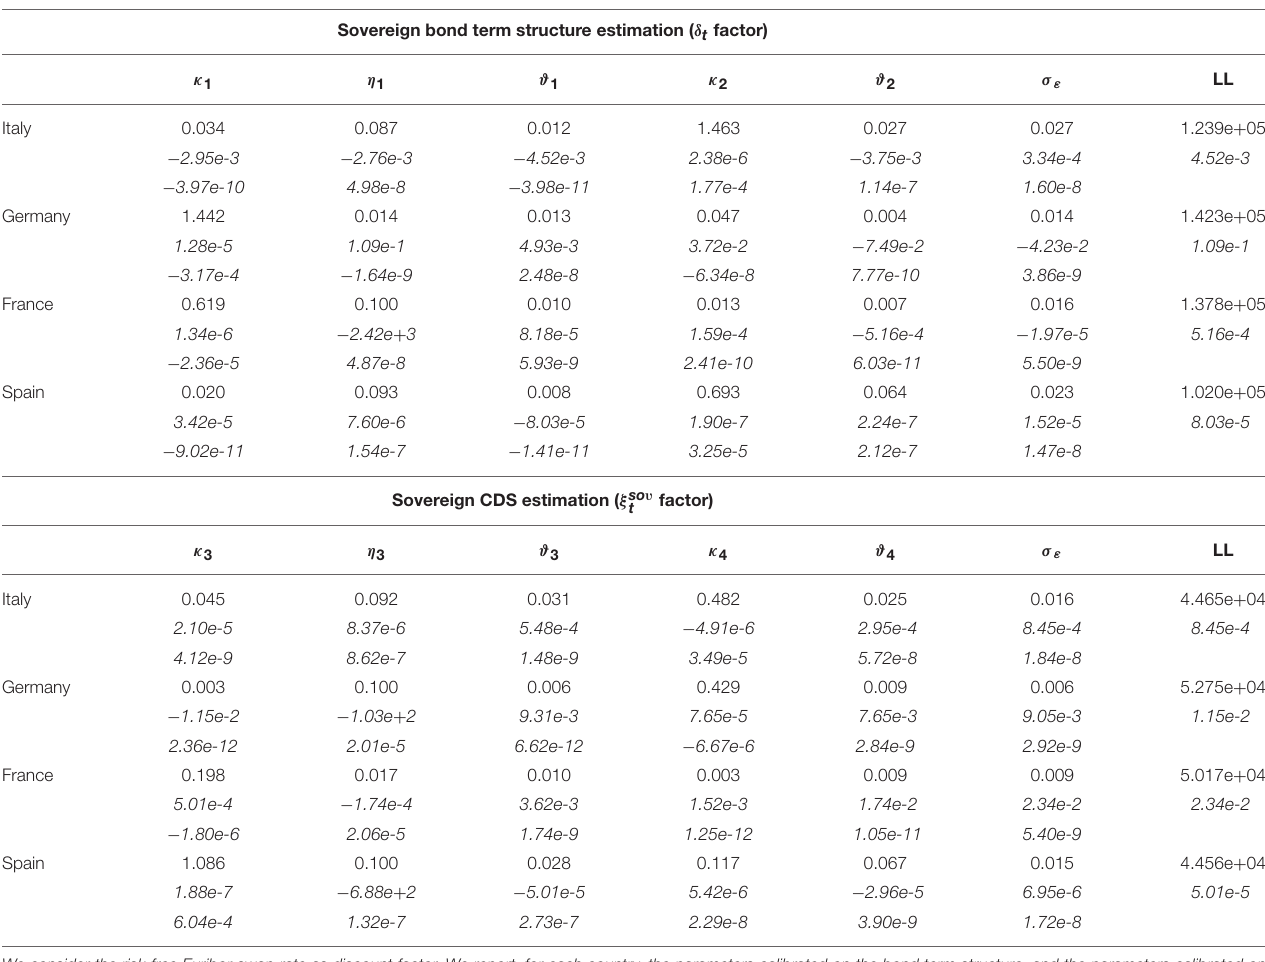
TABLE 5 | Estimated parameters of the multi-factor Vasicek